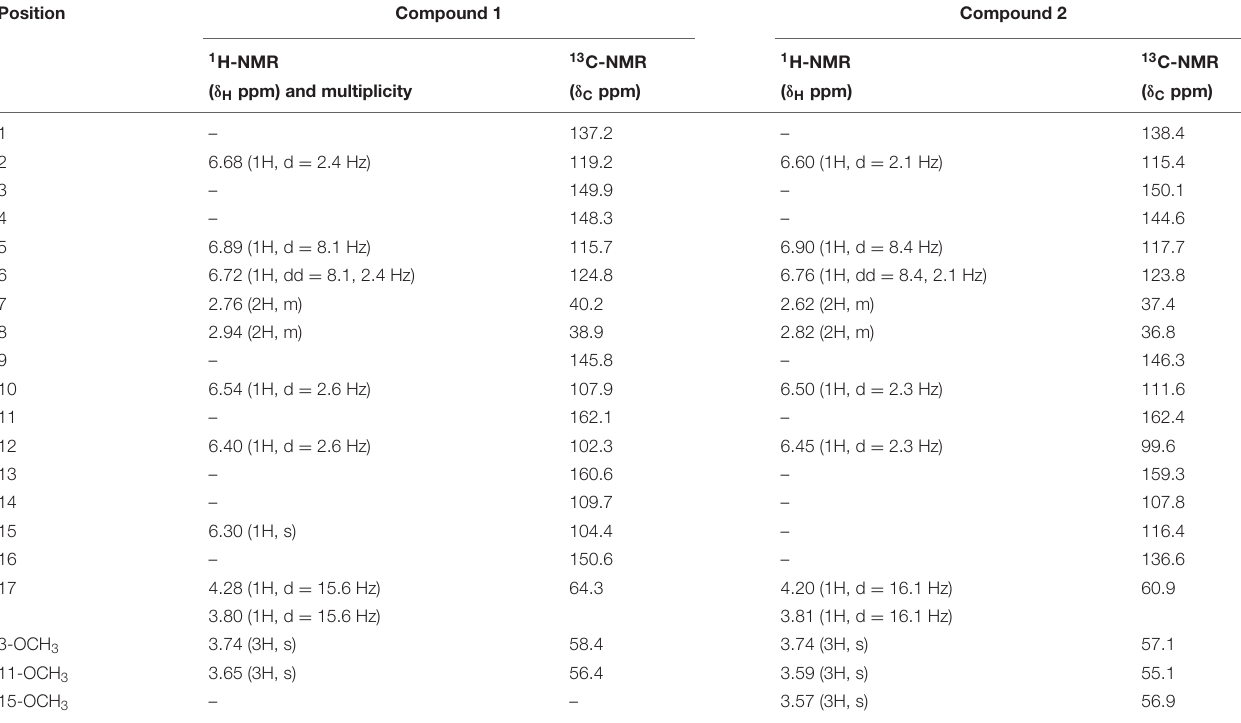
TABLE 1 | 1 H NMR (500 MHz, CDCl 3 ), δ H in ppm and 13 C NMR (125MHz, CDCl 3 ), δ C in ppm of compounds 1 and 2. Position Compound